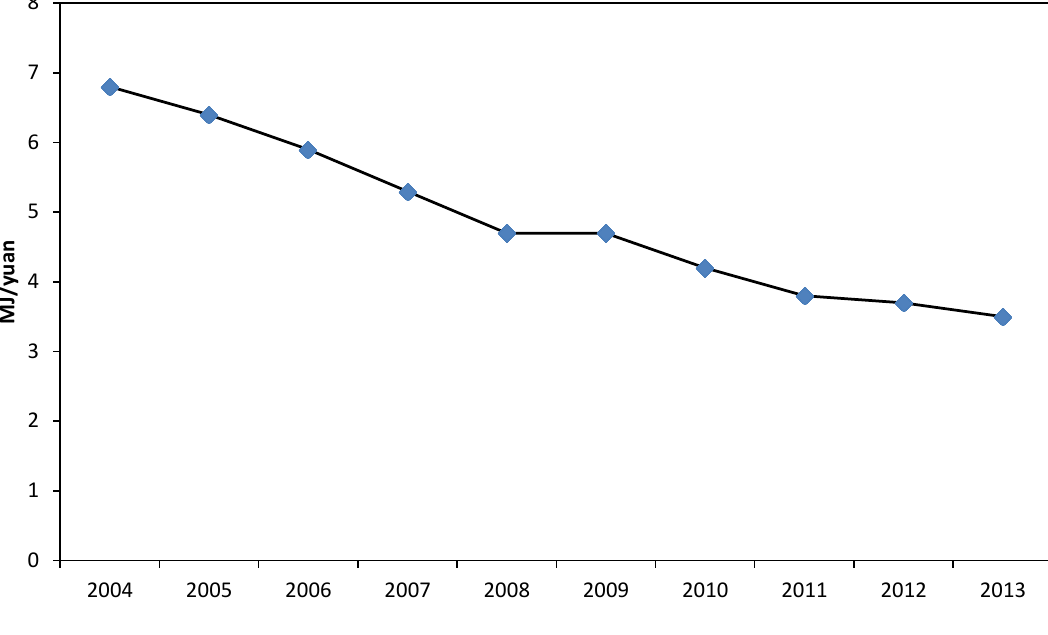
Figure 4. Energy intensity for all industry in China